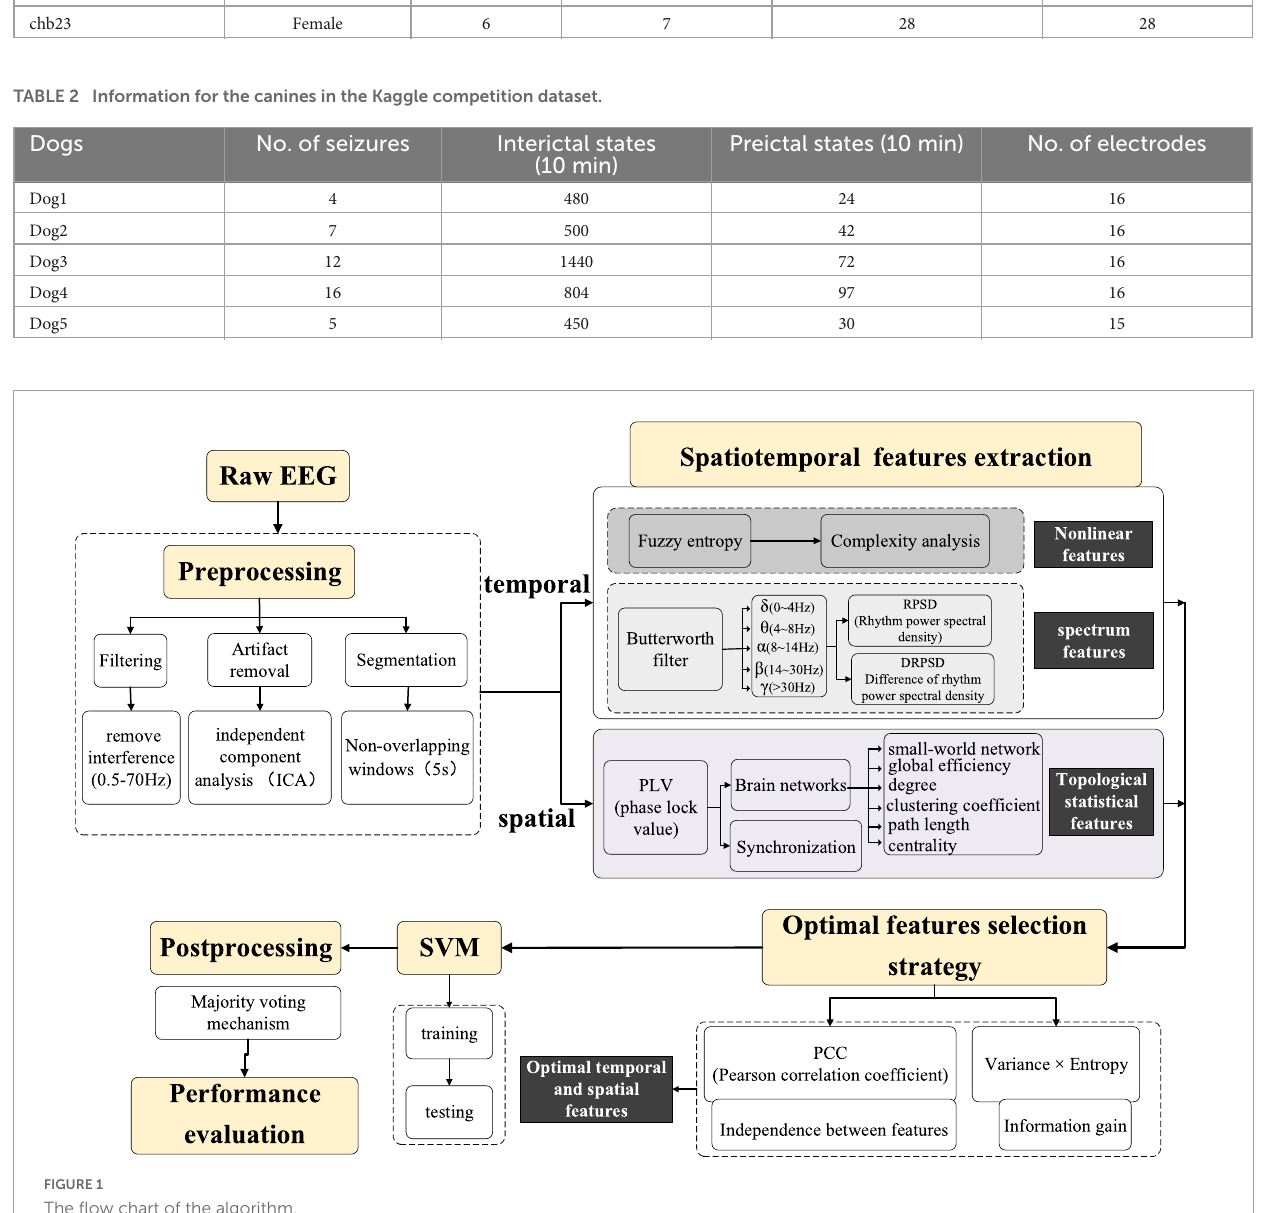
FIGURE1 The flow chart of the